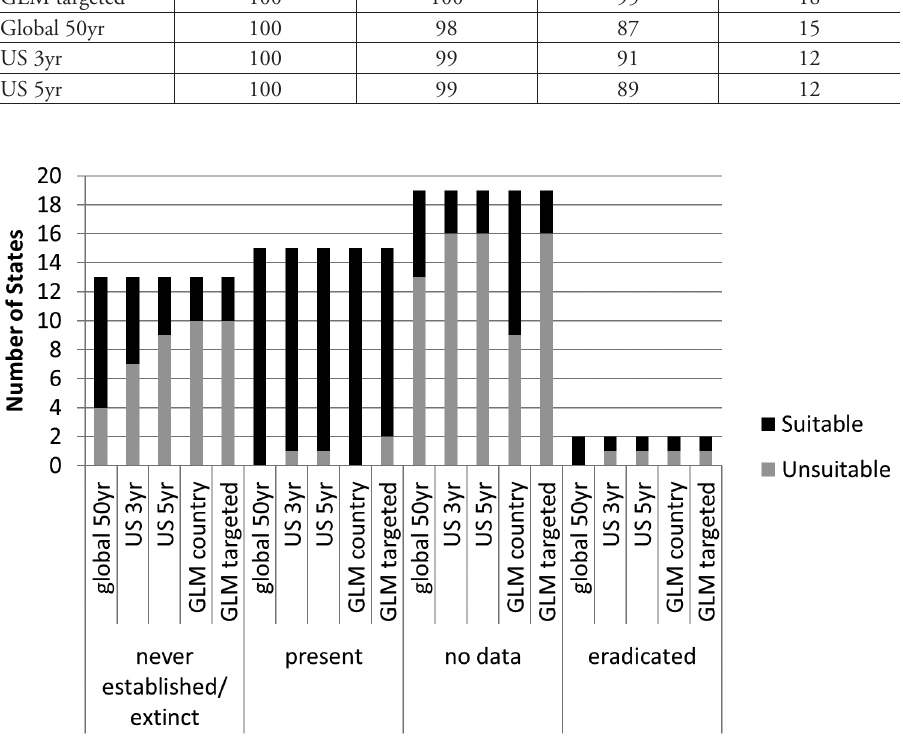
Figure 1. USA state assessment of the five models. The assessment includes the number of USA states classified with at least some suitable (1) or no suitable (0) coypu ( Myocastor coypus [Molina, 1782]) habitat for each coypu status class (never established/ extinct, present, no data, or eradicated) as defined by Carter and Leonard (2002) for each model of the five